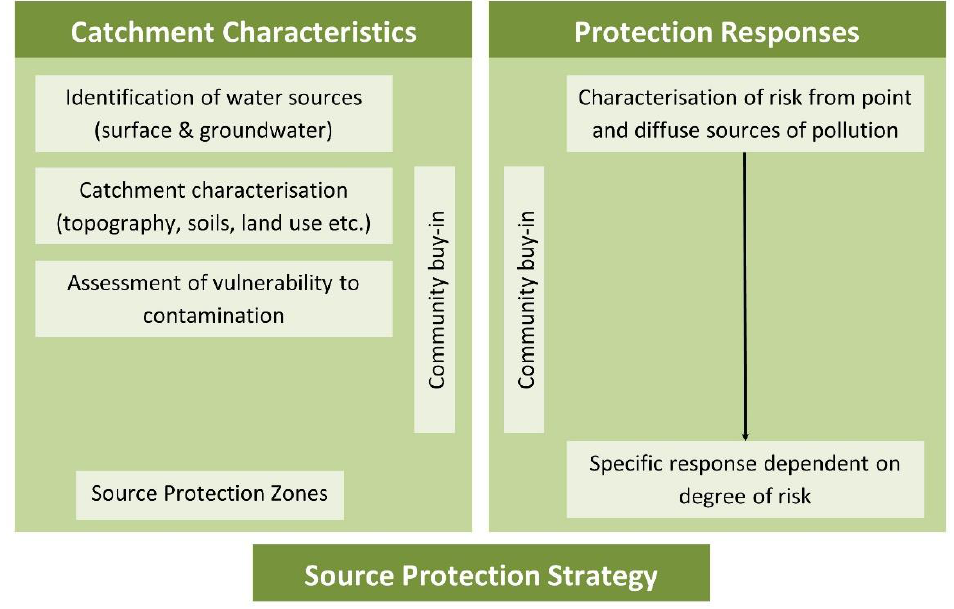
Figure 2. A framework for undertaking preliminary source protection assessments for Group Water Schemes in the Republic of Ireland abstracting from surface water sources (adapted from [1]).